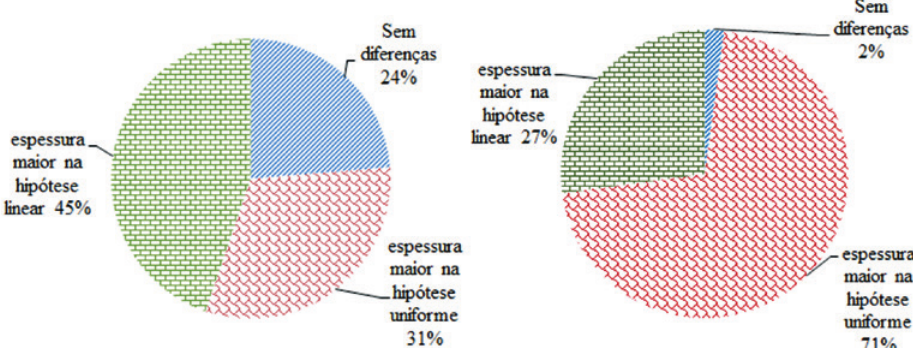
Comparação entre os métodos para o cálculo da espessura da placa de base